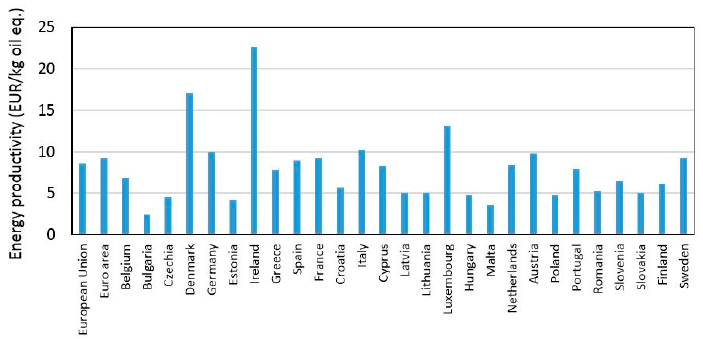
Figure 27. Energy productivity in agriculture in the member countries of the EU in 2020, data from Eurostat [70].